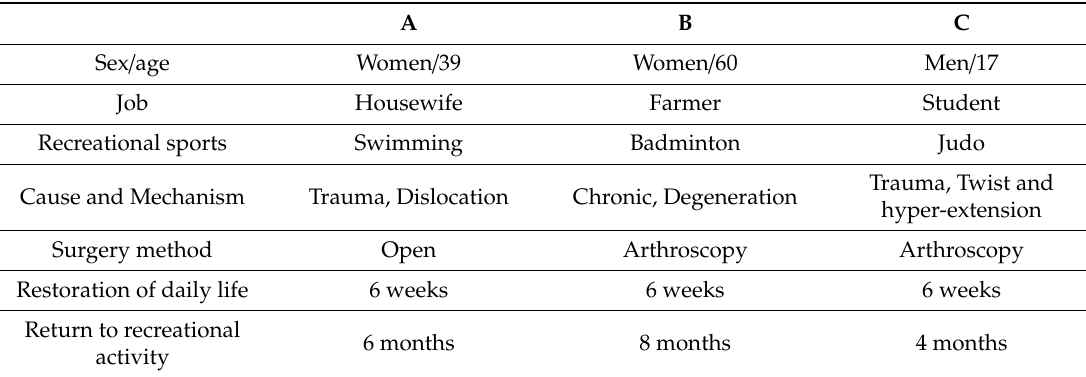
Table 1. Summary of